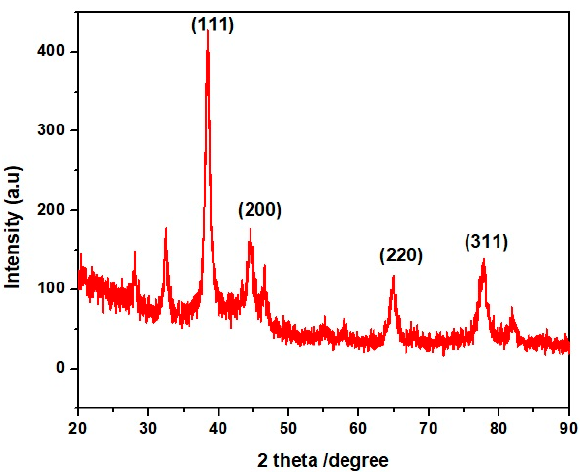
Figure 4. EDX Analysis of AgNPs ( a ) EDX spectrum ( b ) EDX micrograph .